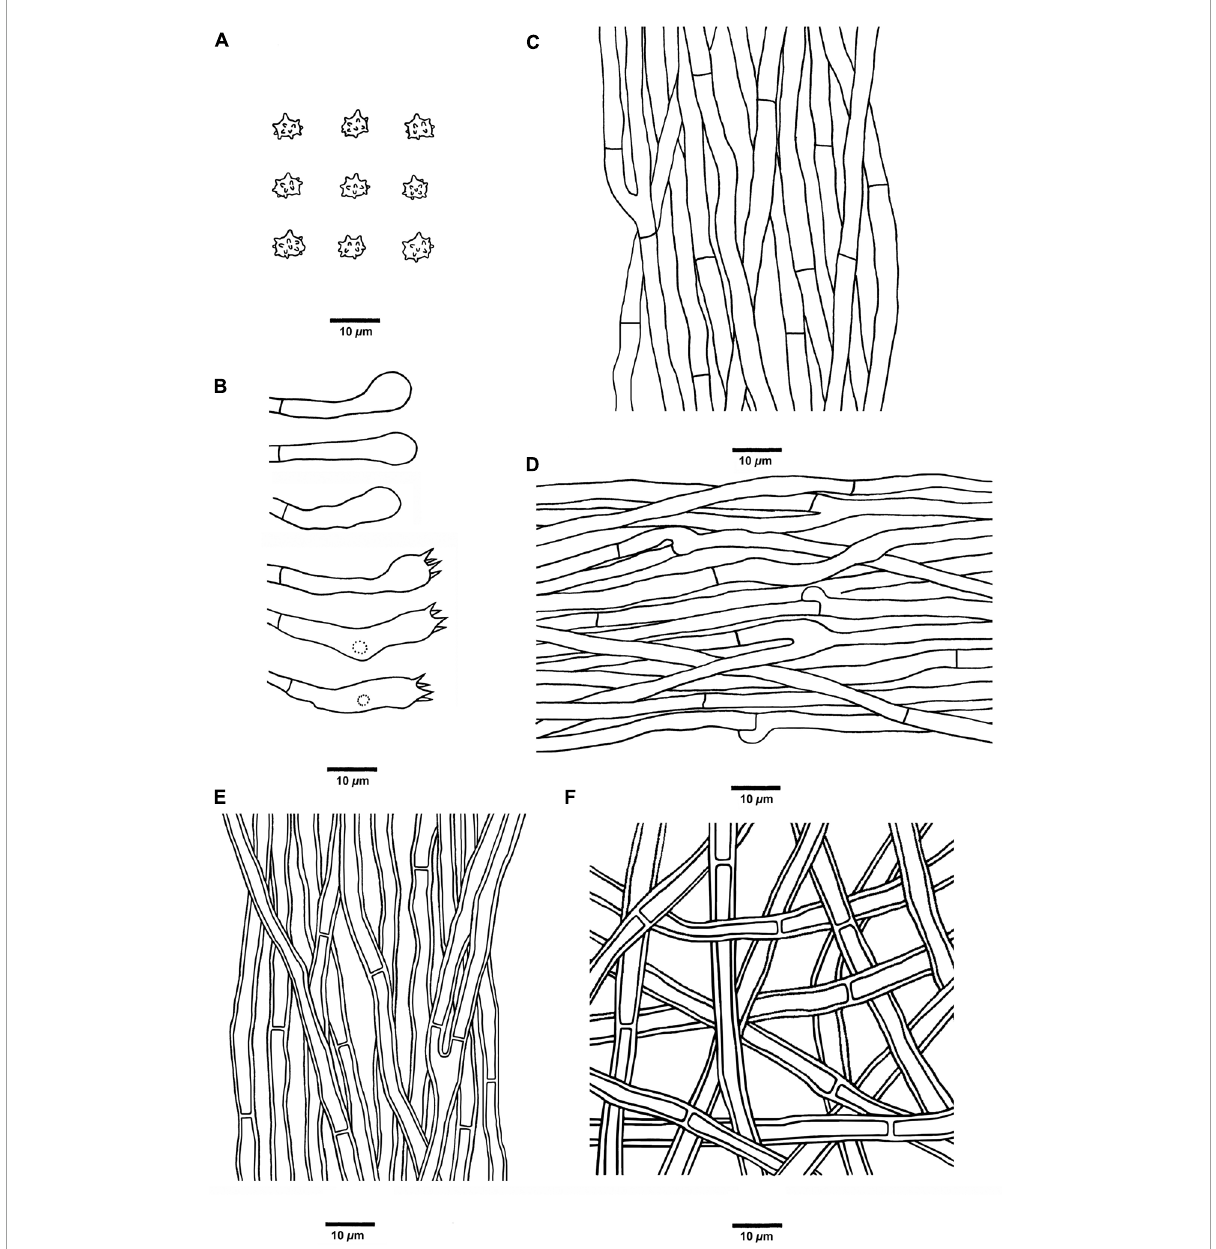
FIGURE6 Microscopic structures of H. concentricum (drawn from Cui 17017). (A) Basidiospores, (B) Basidia and basidioles, (C) Hyphae from context, (D) Hyphae from spines, (E) Hyphae from the inner layer of stipe, and (F) Hyphae from the surface layer of stipe.